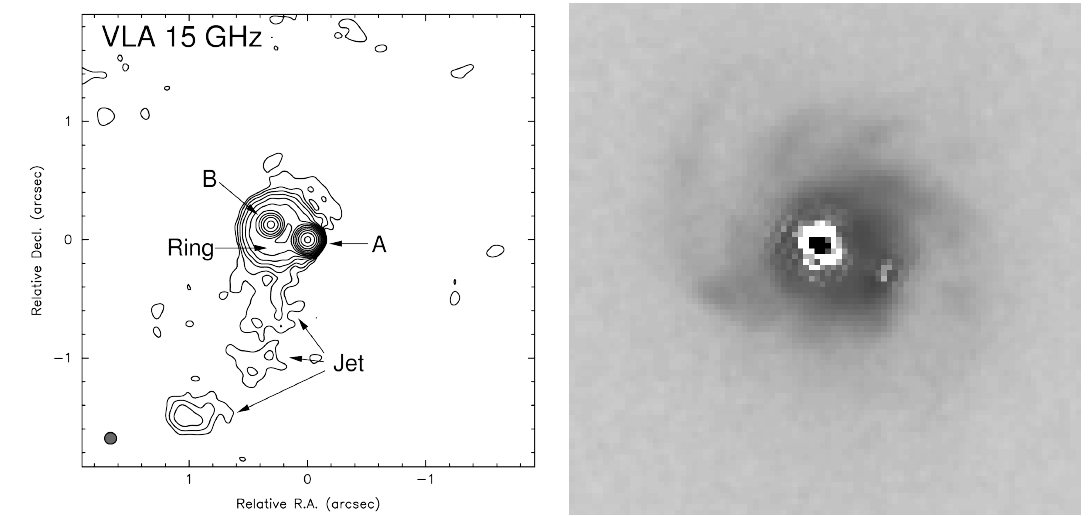
Figure 1. Left : VLA 15-GHz image of B0218+357 illustrating the main features of this lens system—two images (A and B) of a blazar core and an Einstein ring. The ring diameter is similar to the separation of the two lensed images (334 mas). Right : HST I -band image taken using the Advanced Camera for Surveys (Figure 7 of [7]). The lensed images have been removed to reveal the underlying galaxy more clearly. Note the prominent spiral arms. The images are on different